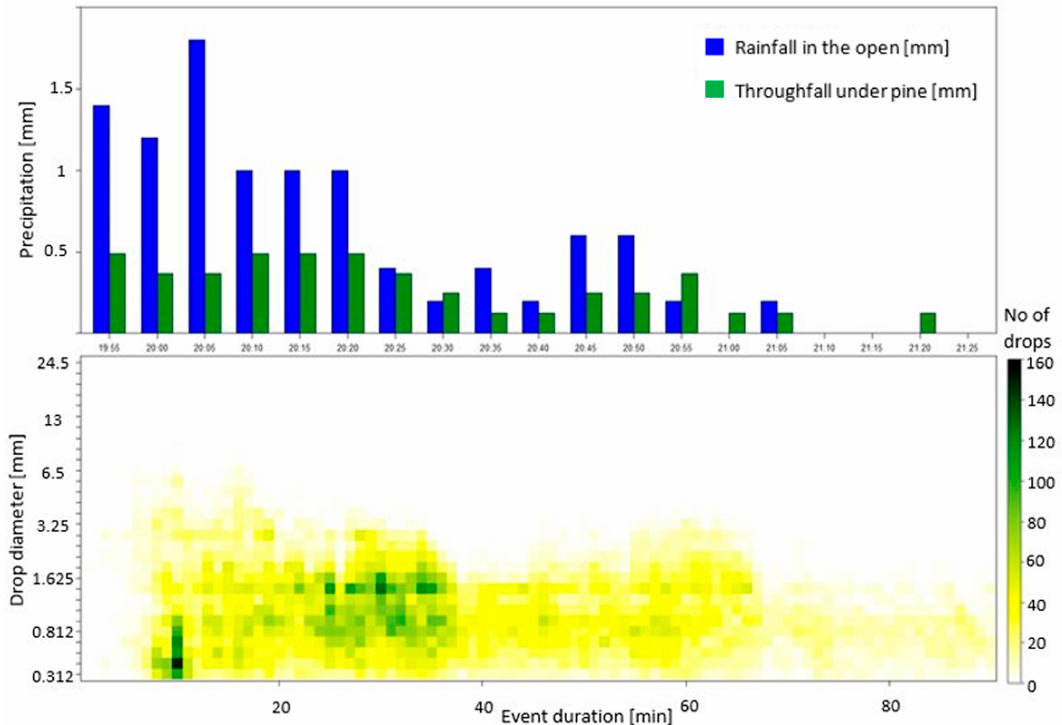
Figure 6. Rainfall and throughfall under the pine in 5-min time interval (upper panel) and drop size distribution in 1-min time interval (bottom panel) for the 13 June 2014